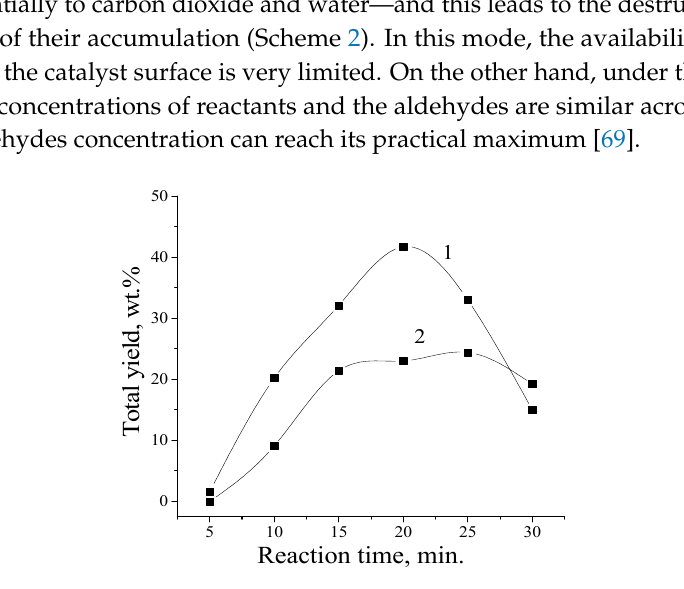
Figure 1. Total yield of the aromatic aldehydes versus process duration in the catalytic oxidation of birch wood by oxygen at 170 ◦ C [51]. (1) 50 g/L loading of wood powder, (2) 100 g/L loading. Int. J. Mol. Sci. 2017 , 18 , 2421 8 of